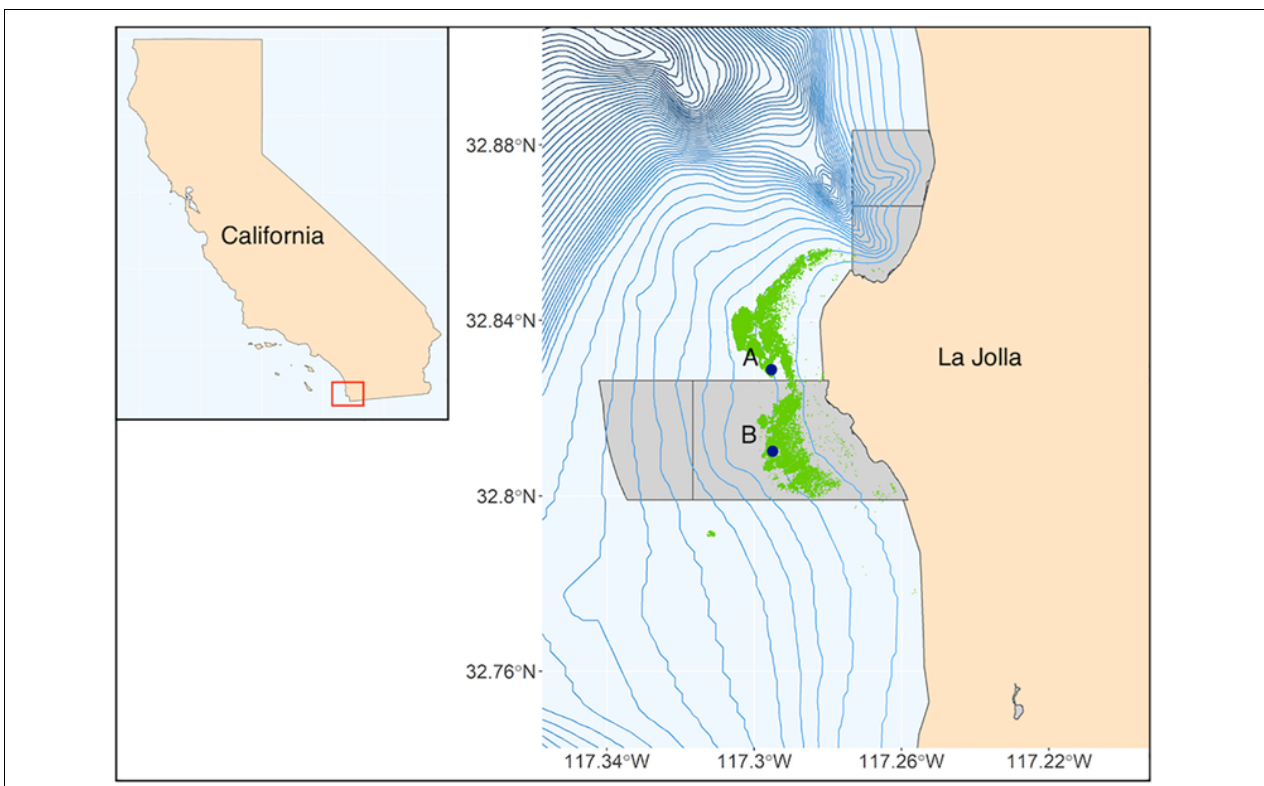
FIGURE 1 | State of California (inset) with study area highlighted by red box. Site locations (indicated by dark blue points) off the coast of Southern California. Marine protected areas are denoted by light gray polygons; blue lines are 10-m isobaths; kelp forest extent is indicated in green.